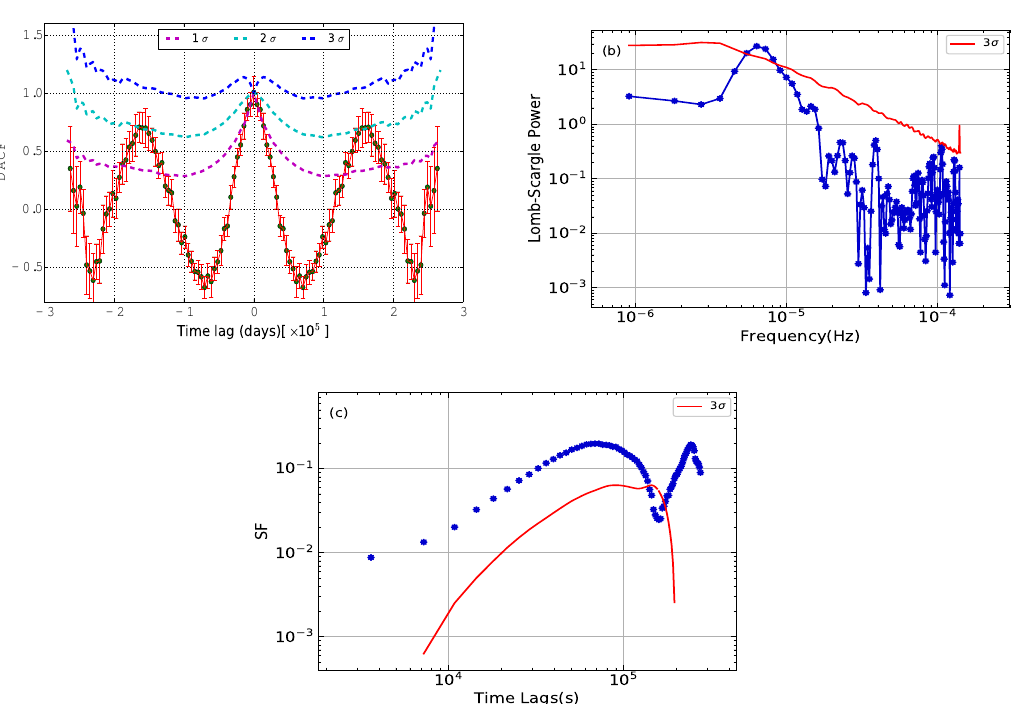
Figure 2. ( a ) DACF of the source; ( b ) LSP with a peak at a period of 156,250 s; ( c ) SF curve showing period at ∼ 154,800 s. The corresponding 1 σ , 2 σ or 3 σ confidence contours (see Section 3.5) are also added in the respective